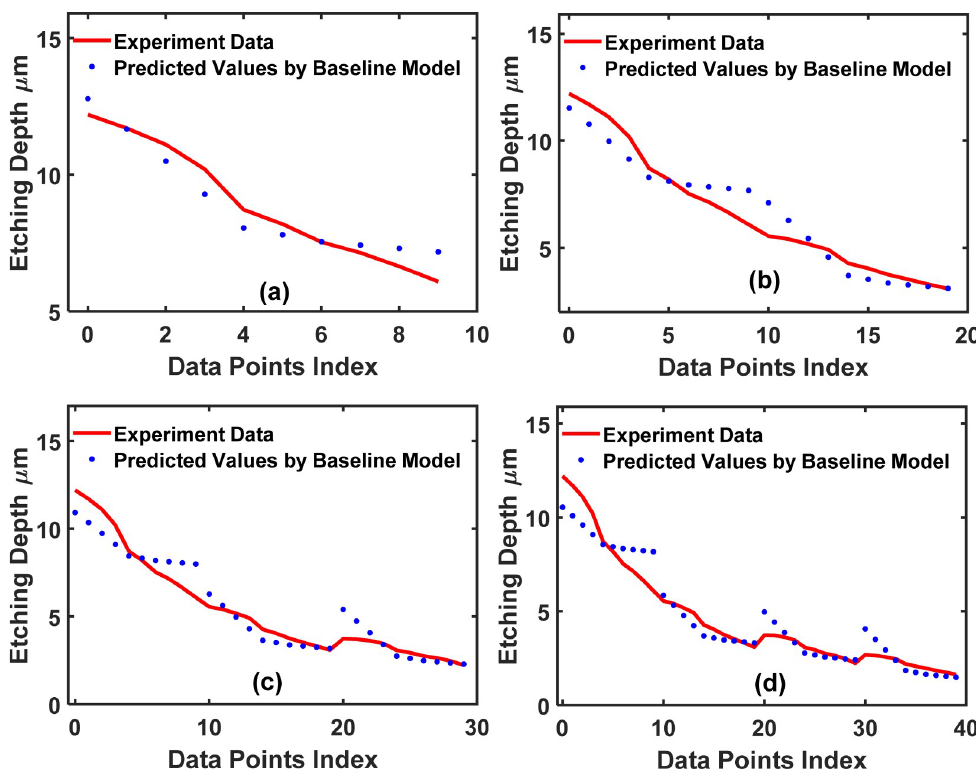
Fig 13. Training set fitting for the 5-input dataset using the baseline conventional NN. The partition values, 10, 20, 30 and 40, are shown in (a), (b), (c) and (d), respectively.